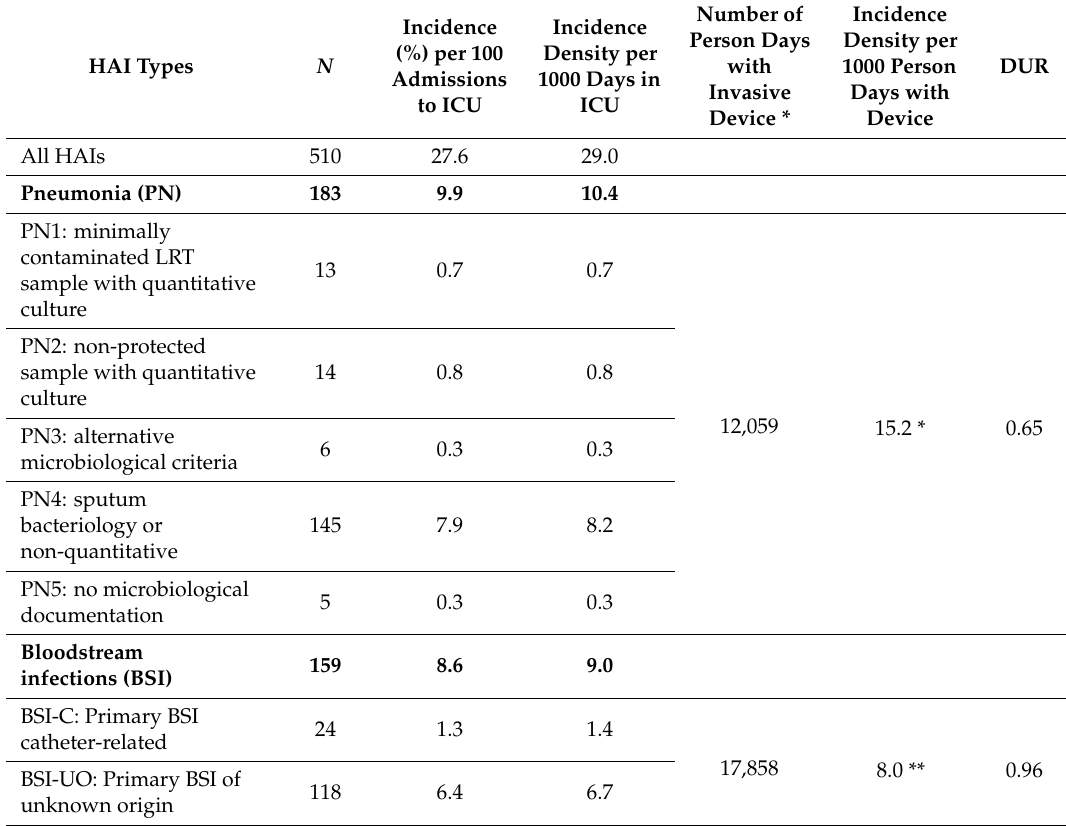
Table 1. Number of HAIs/100 admissions (%), number of HAIs/1000 person days ( n /1000),